Question: Provide a one-line summary of what is displayed.
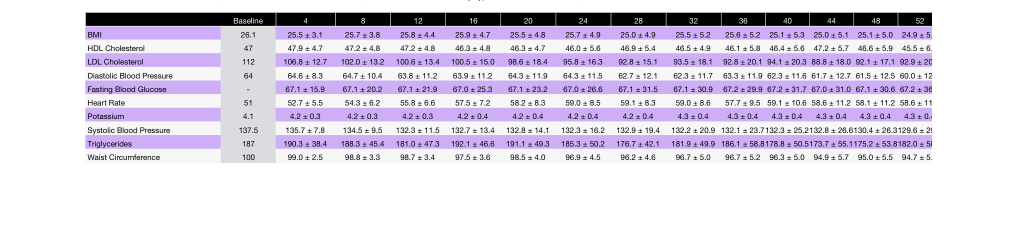
Answer: An example twin record for a single DLD patient is shown, which reports the mean and standard deviation of the twins for that patient. A sample of static baseline information is given at the top of the record. A sample of longitudinal outcomes predicted by the model are supplied as rows, with columns indicating the time in months since baseline visit.